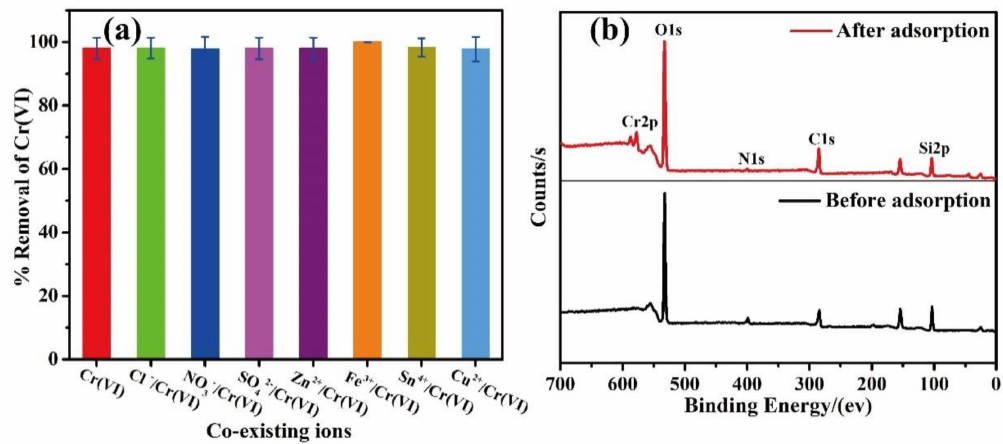
Figure 5. ( a ) The e ff ect of coexisting ions on Cr(VI) adsorption by PPy / HMSNs and ( b ) XPS spectra of PPy / HMSNs before and after